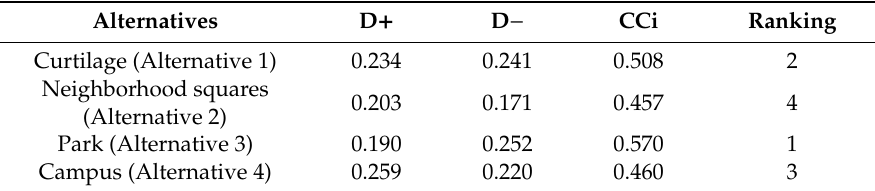
Table 4. Ranking results of